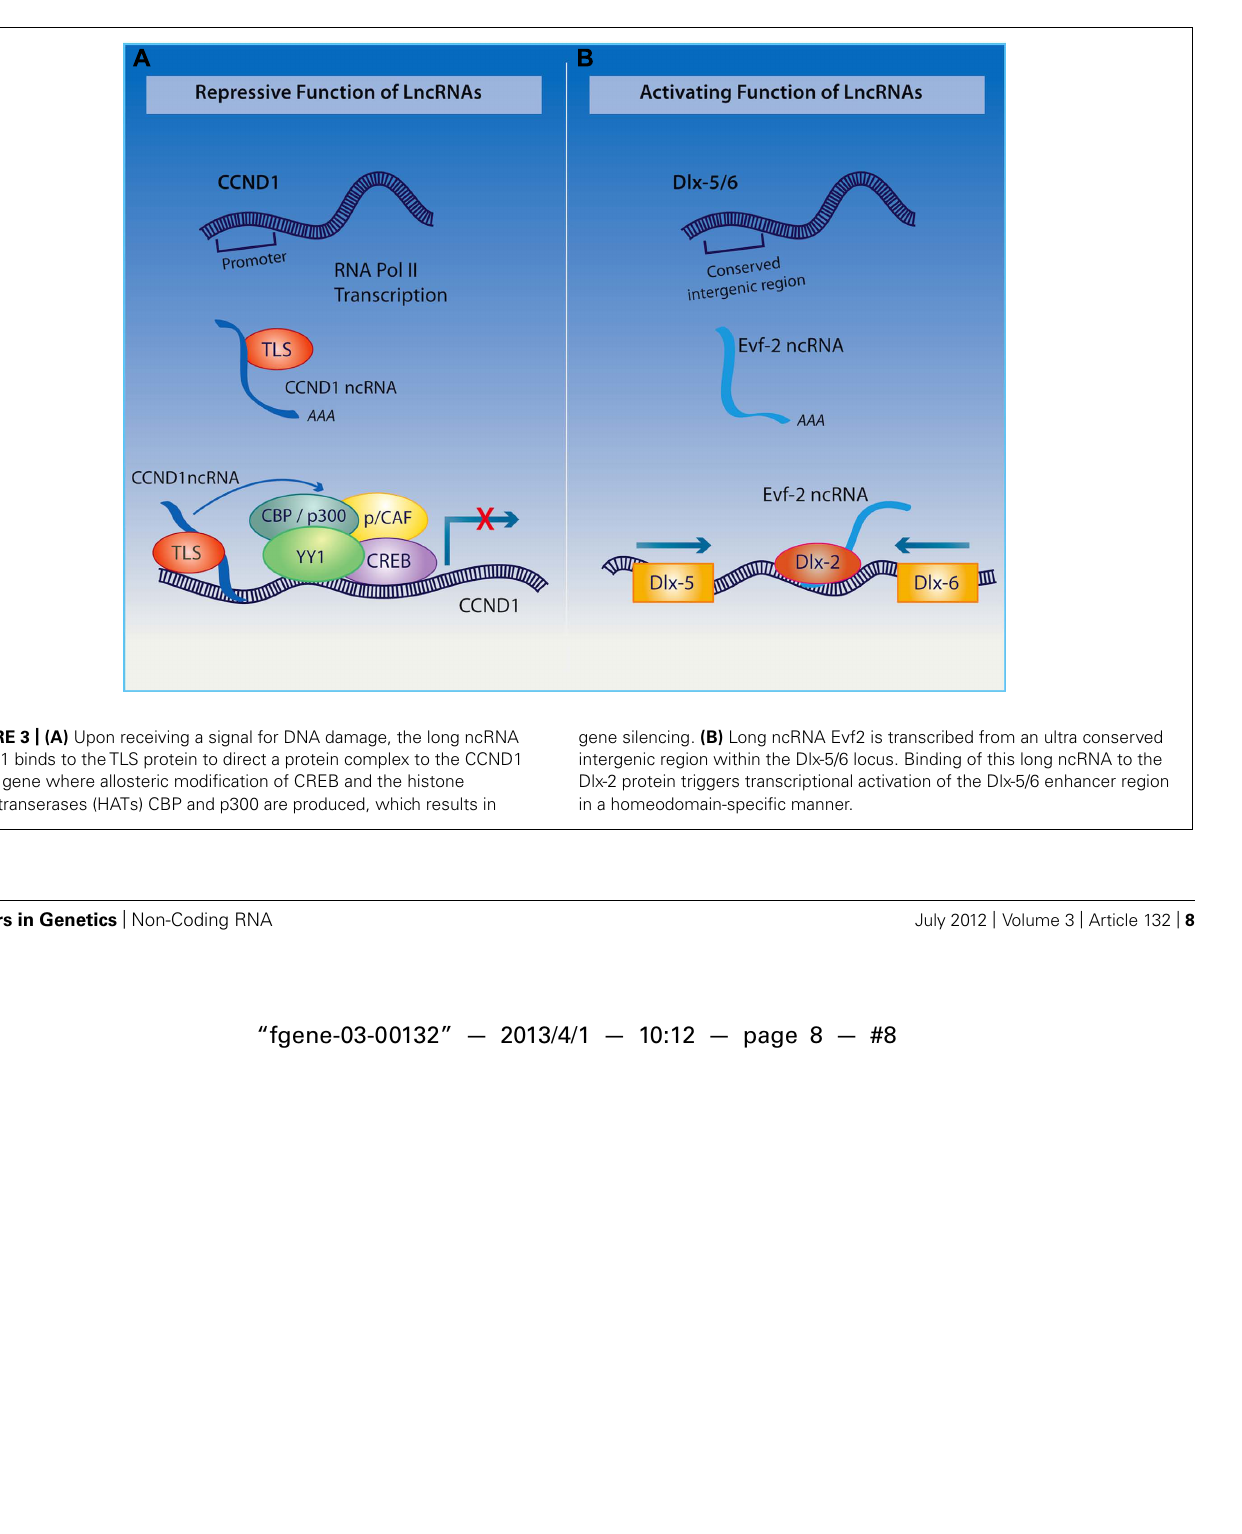
Frontiers in Genetics | Non-Coding